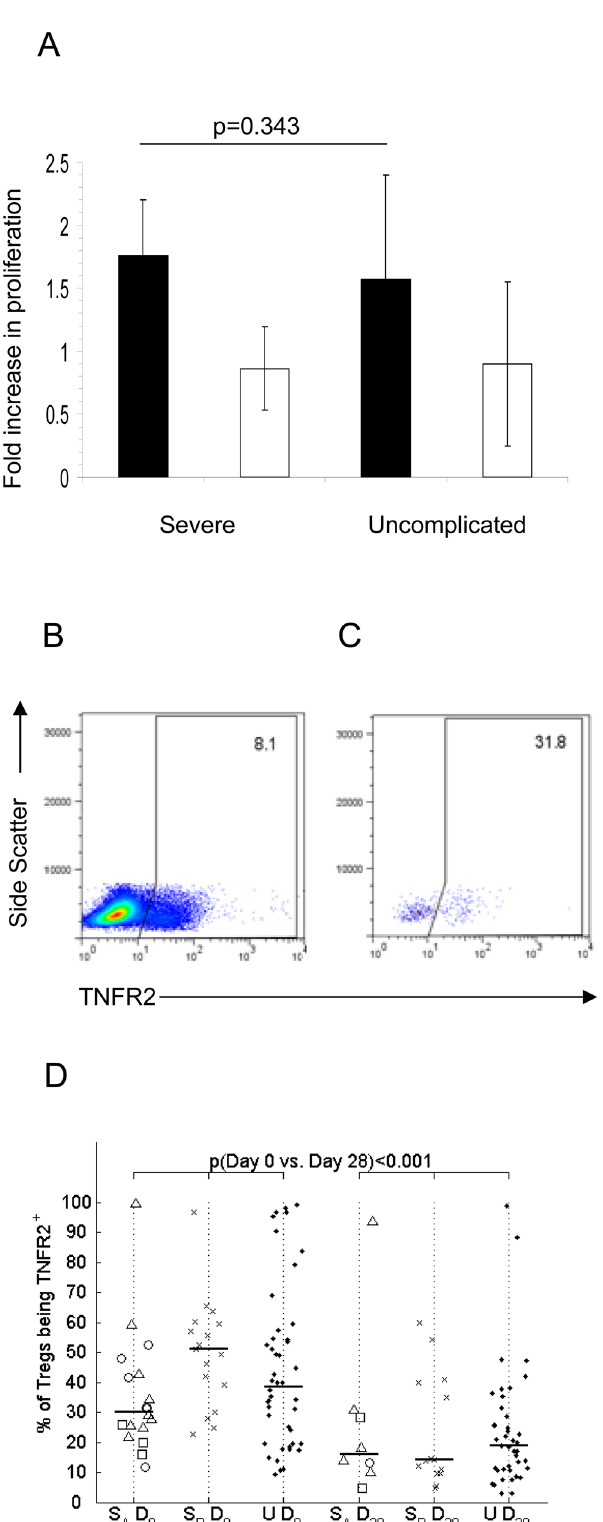
Figure 4. Tregs from severe and uncomplicated cases have similar functional capacity. (A) PBMC from 10 severe and 10 uncomplicated cases collected on day 0 were depleted of CD25 + hi cells or mock depleted using magnetically labelled beads (Dynal), and assessed for proliferation using [3H]-thymidine after 6 days in culture with P. falciparum shizont extract (PfSE), uninfected red blood cells (uRBC), PMA + Ionomycin (P + I), or growth medium (GM),